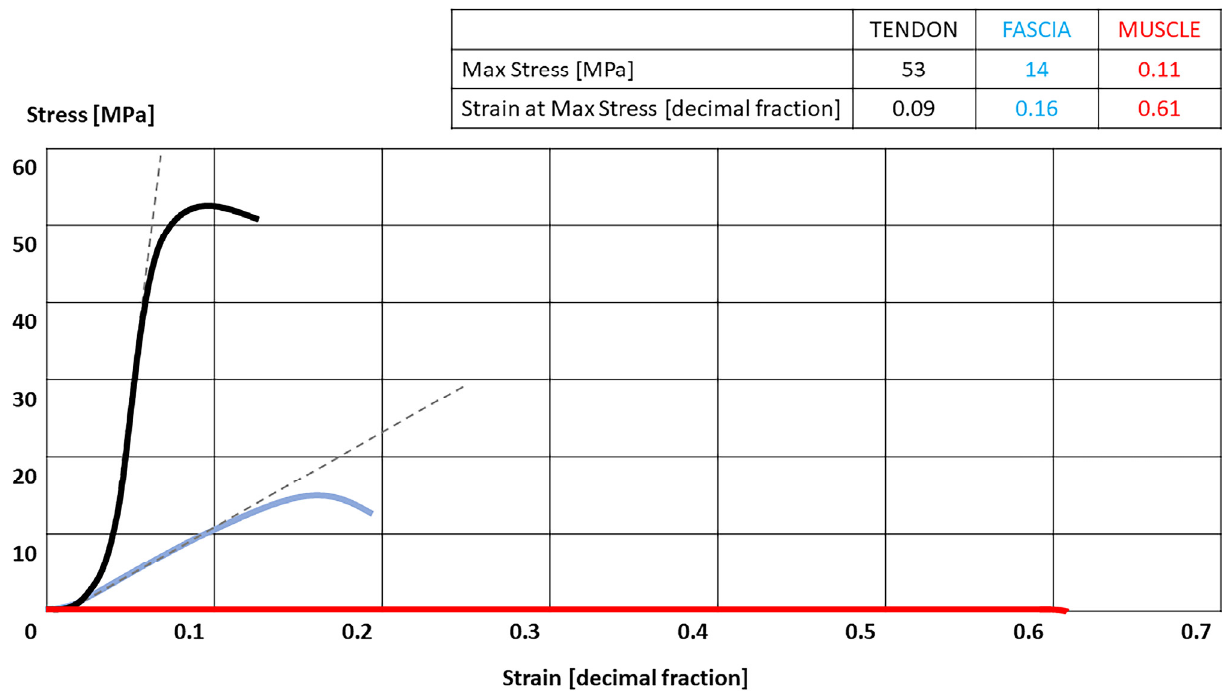
Figure 2. Stress-strain curves of the tendon, fascia [45] and muscle [46]. Tendon = black; fascia = blue; Muscles = red. Table present the highest Stress that each tissue can tolerate with their correspondence strain.